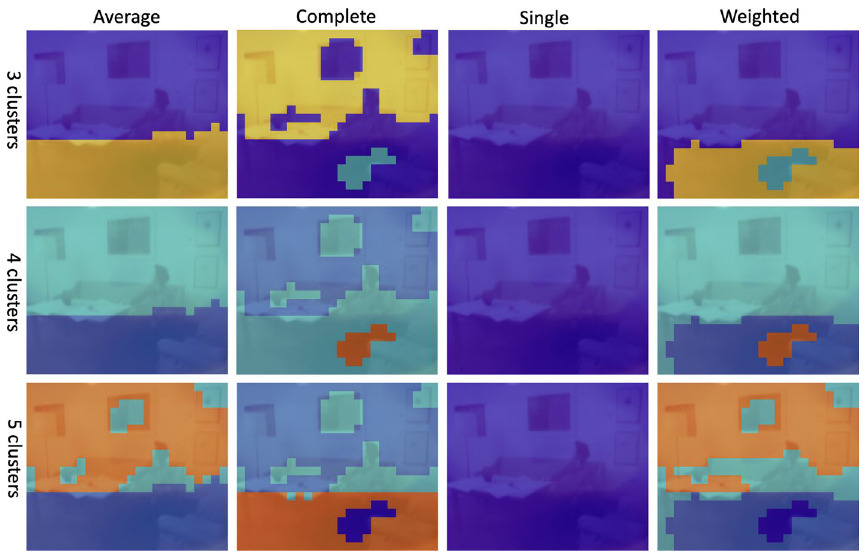
Fig. 8 Segmentation results varying the agglomeration method, using a grid size of 50 Chebyshev